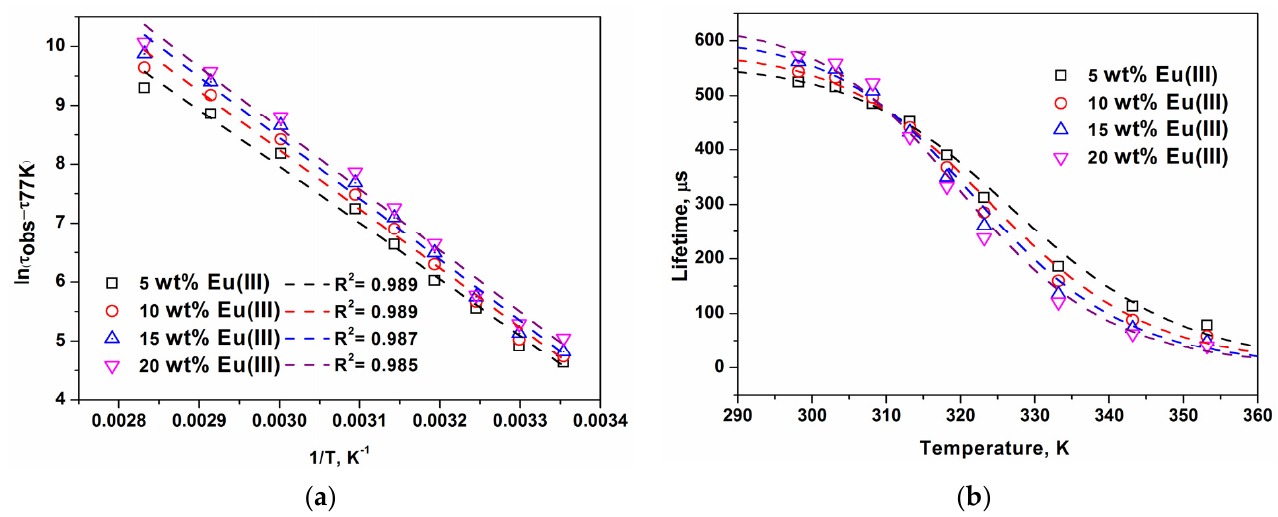
Figure 6. Arrhenius plot of the lifetime ( a ) and the simulated lifetime ( b ) as the functions of temperature obtained for PLA composite films doped with different amounts of the Eu(III) complex at λ ex = 340 nm and λ em = 613 nm (marker symbols—experimental data, dashed lines—approximations). Table 2. The frequency factor and activation energies of the PLA composite films doped with different amounts of the Eu(III) complex and similar